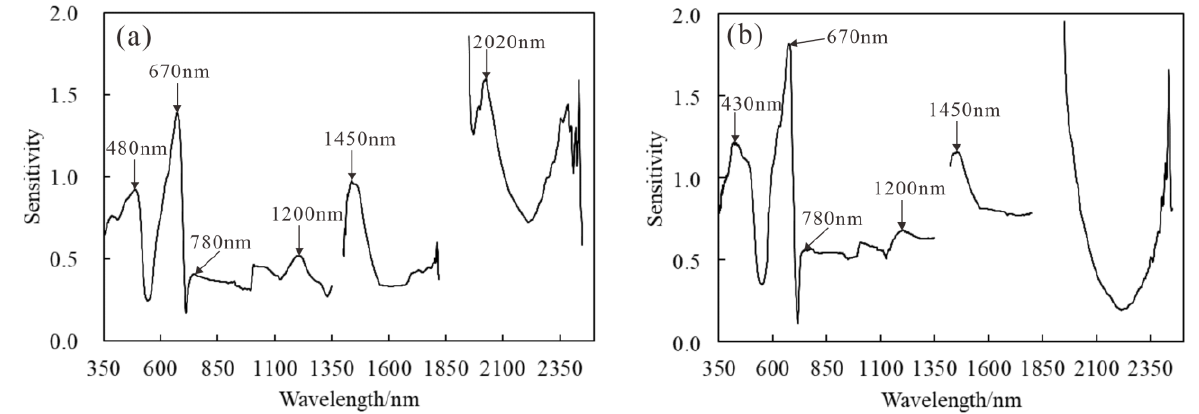
Figure 5. Sensitivity analysis of crop canopy spectral reflectance at different water stress levels. ( a ) Soybean; and ( b ) maize.